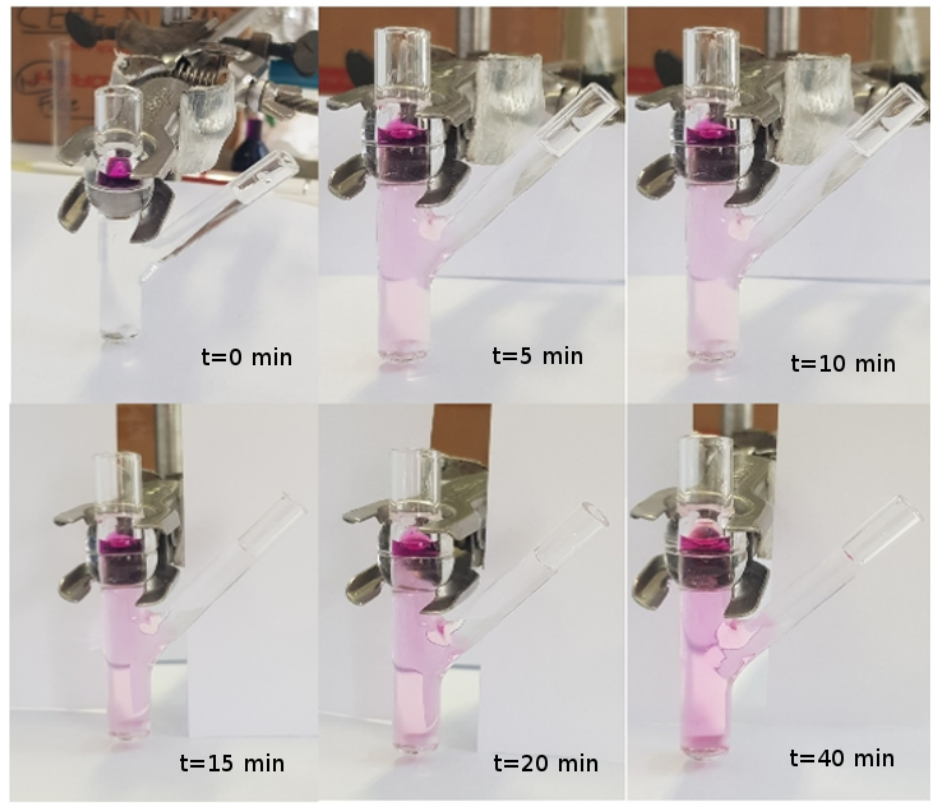
Figure 3. Release experiment in an unjacketed Franz cell at T = 25 ◦ C with a colored marker (KMnO 4 0.1 M in distilled water). Rotational speed: 500 rpm. The reason why the color is much fader in this experiment as compared to that with 100 rpm—the concentration of KMnO 4 being the same—is only a matter of colors in the photo (different camera and different light